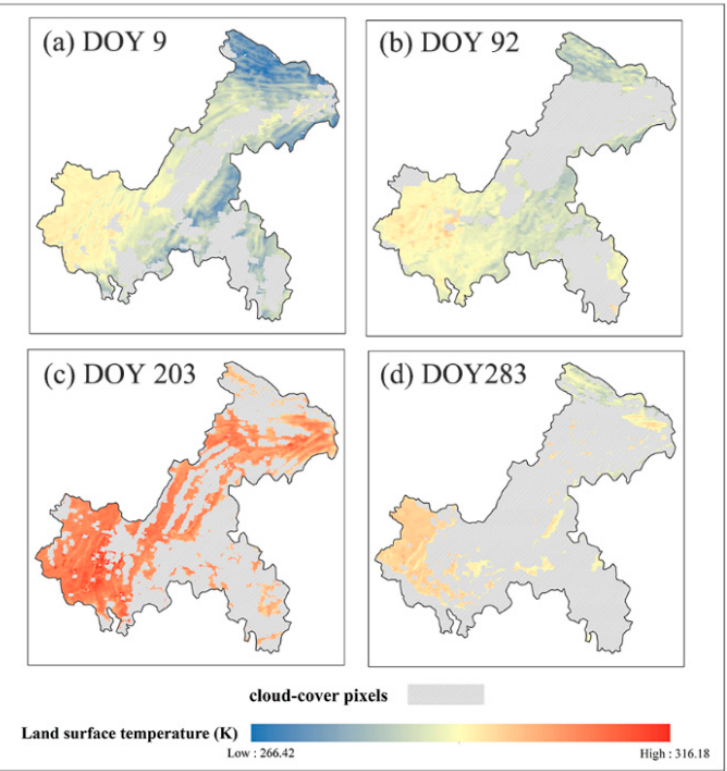
Figure 4. Original MODIS/Terra daytime LST images on four days in 2018 (DOY 9, DOY 92, DOY 203 and DOY 283).